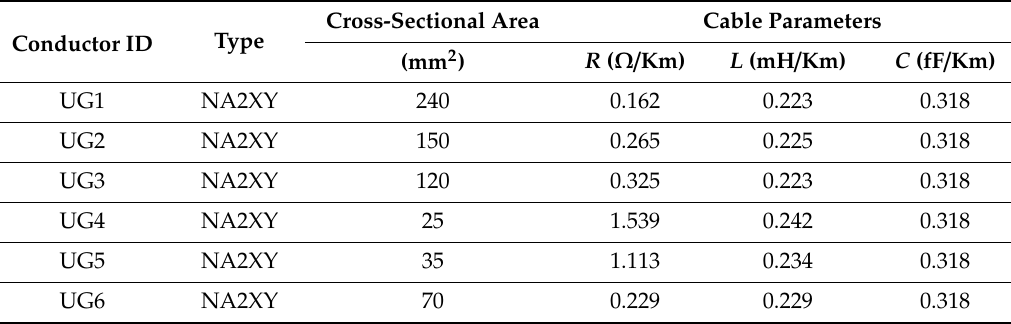
Figure 2. Constant power load.